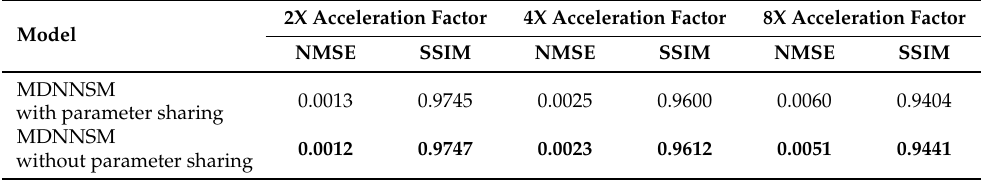
Quantitative evaluation of reconstructed T1-weighted images depending on the shared